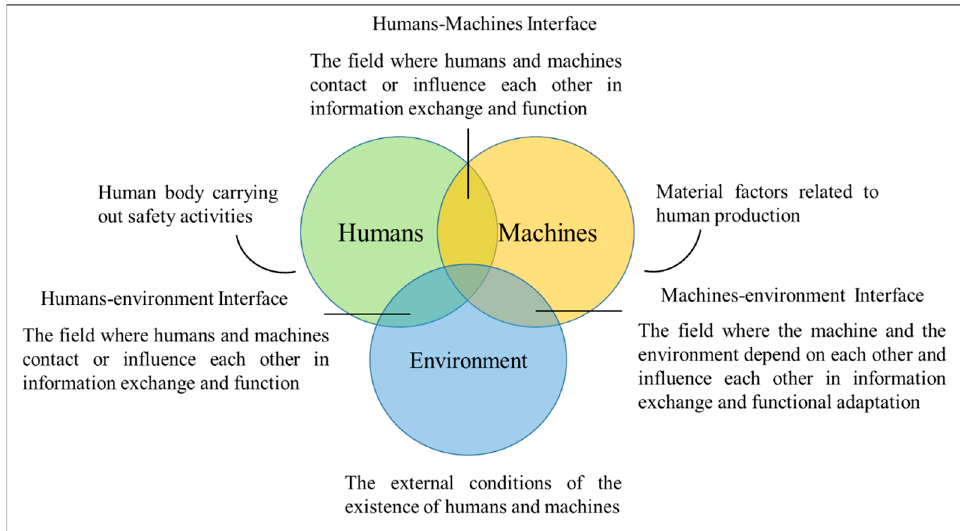
Figure 2. Research object of safety ergonomics. The main research objects of safety ergonomics include humans, machines, and the environment, as well as the interactive interface between various elements.